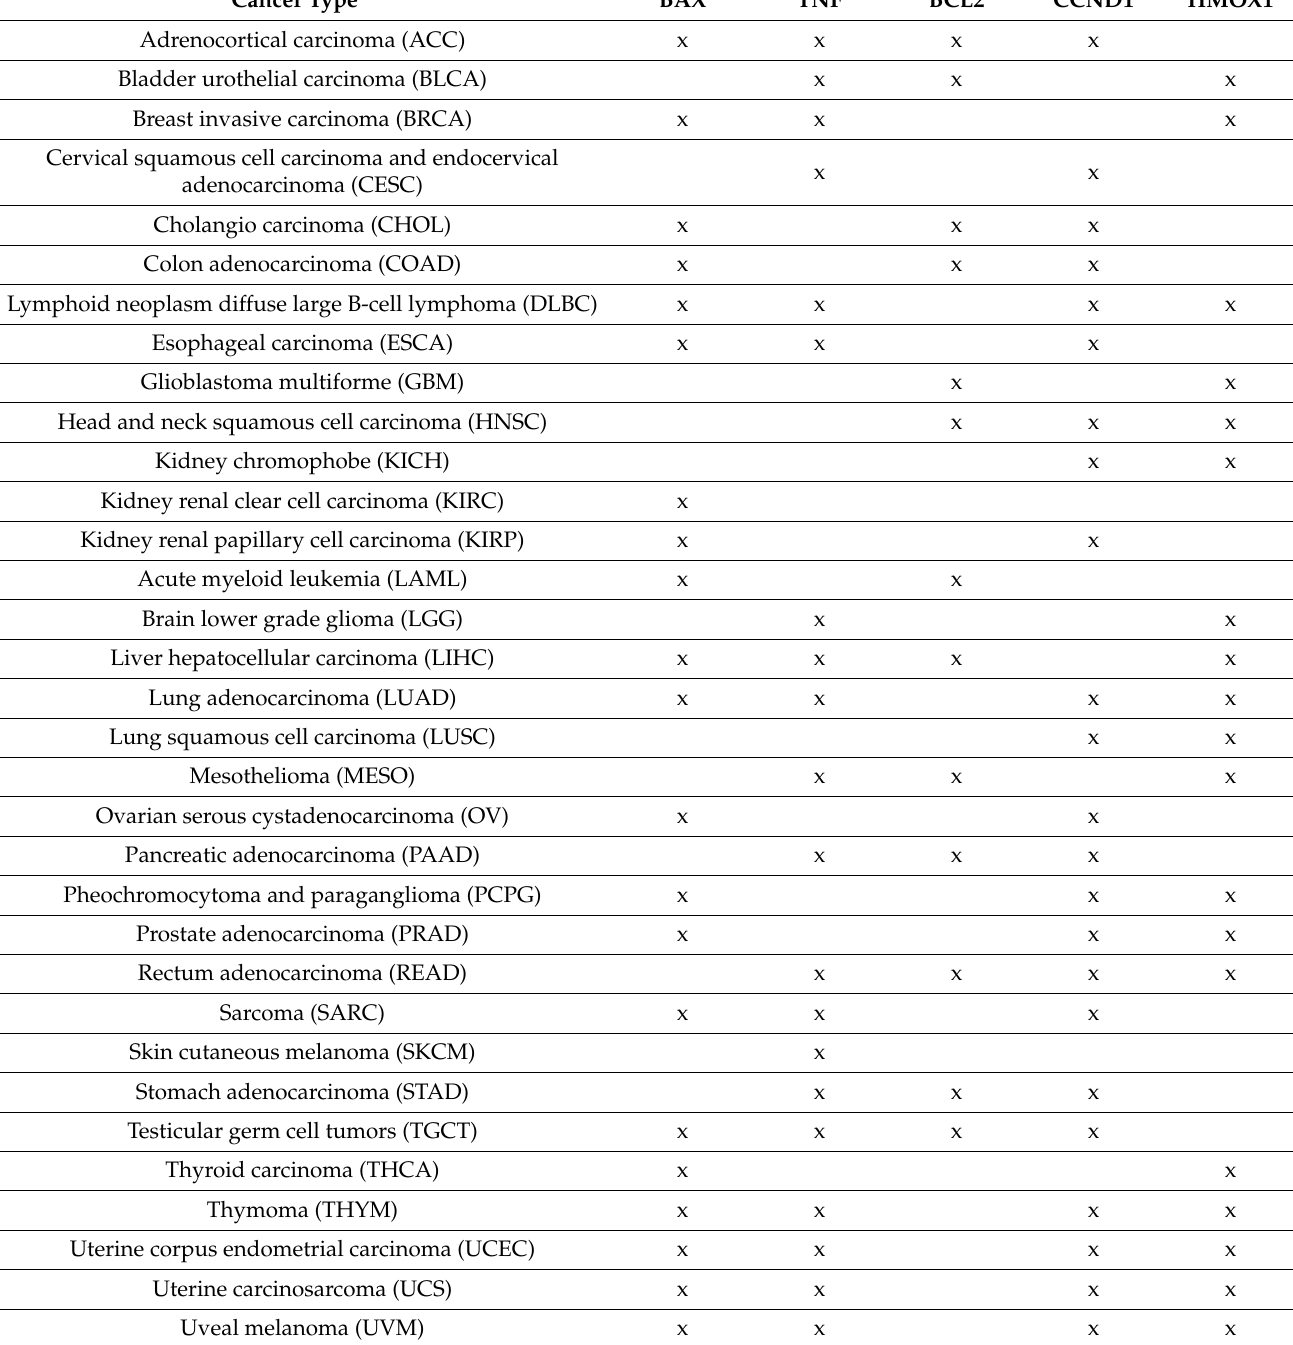
Table 1. List of TCGA cancer types and prognosis-associated with prognosis in the corresponding malignancy. Cancer Type * BAX TNF BCL2 CCND1 HMOX1 Adrenocortical carcinoma (ACC) x x x x Bladder urothelial carcinoma (BLCA) x x x Breast invasive carcinoma (BRCA) x x x Cervical squamous cell carcinoma and endocervical adenocarcinoma (CESC)